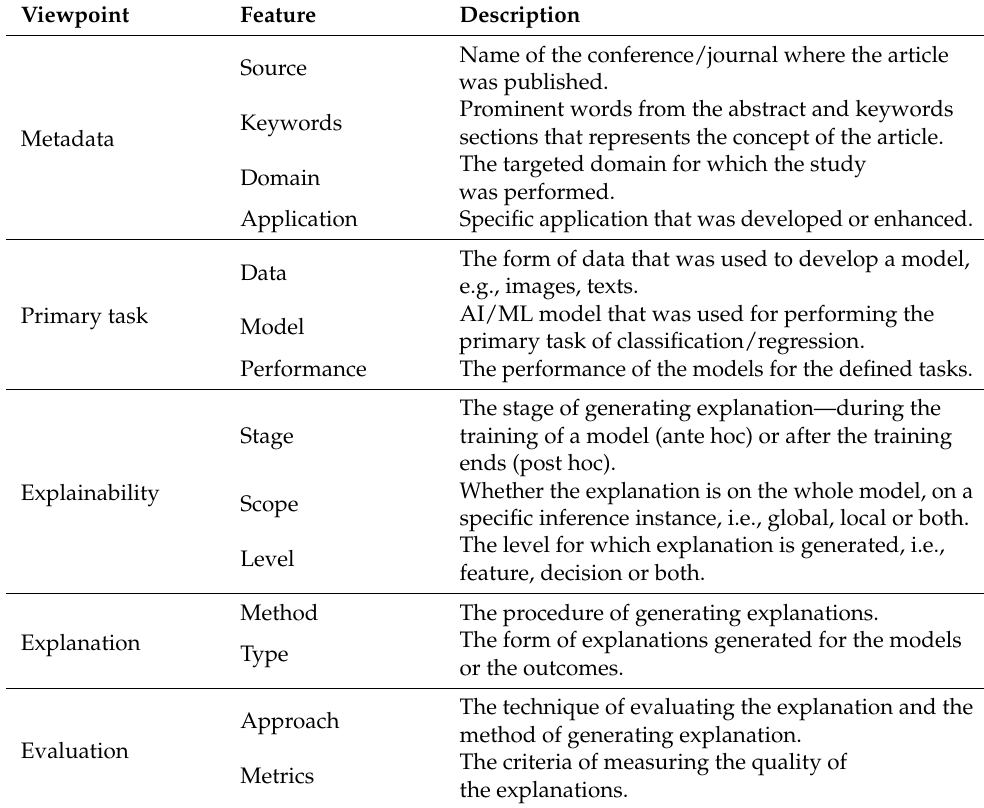
Table 3. List of prominent features extracted from the selected